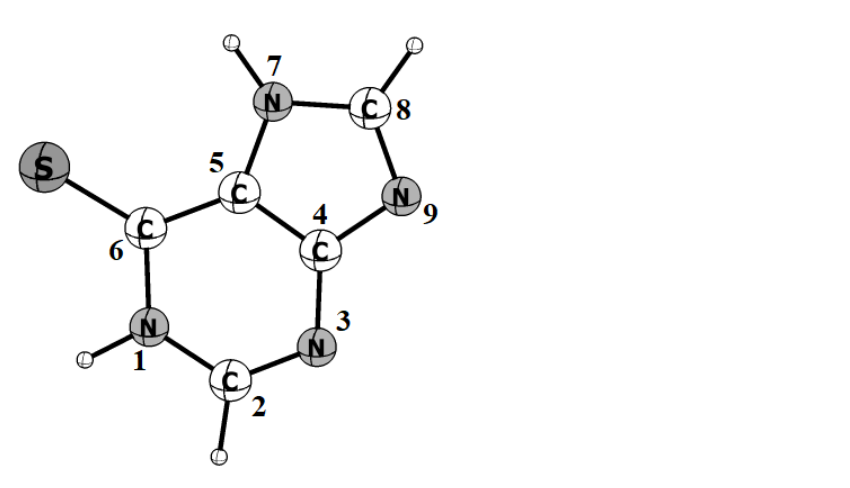
Scheme 1. Chemical structure and atom numbering for 6-mercaptopurine